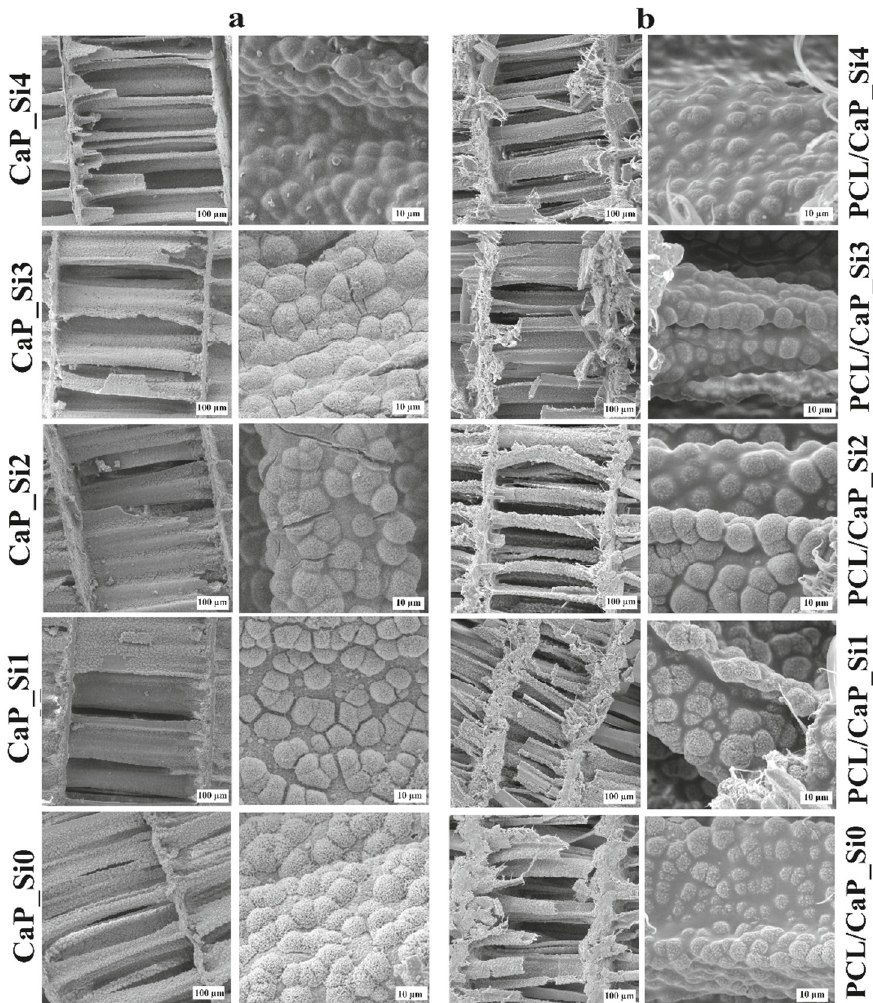
Figure 5. SEM micrographs of calcium phosphate scaffolds doped with silicon before ( a ) and after ( b ) impregnation with PCL. Scale bar: 100 and 10 μm.